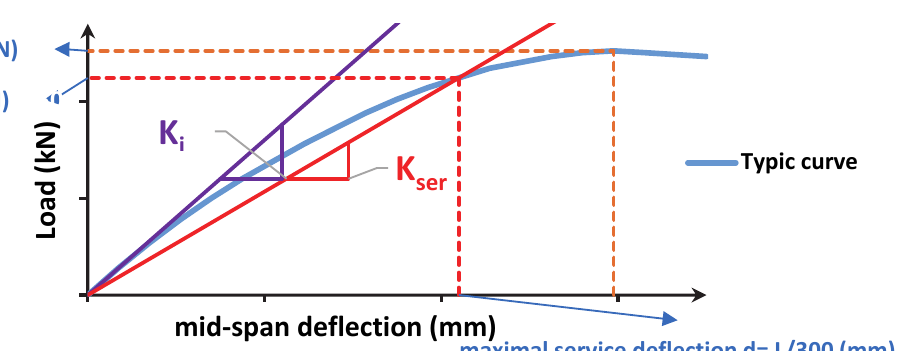
Figure 18: Typical load–mid-span deflection curve of the under-designed TCC beam.